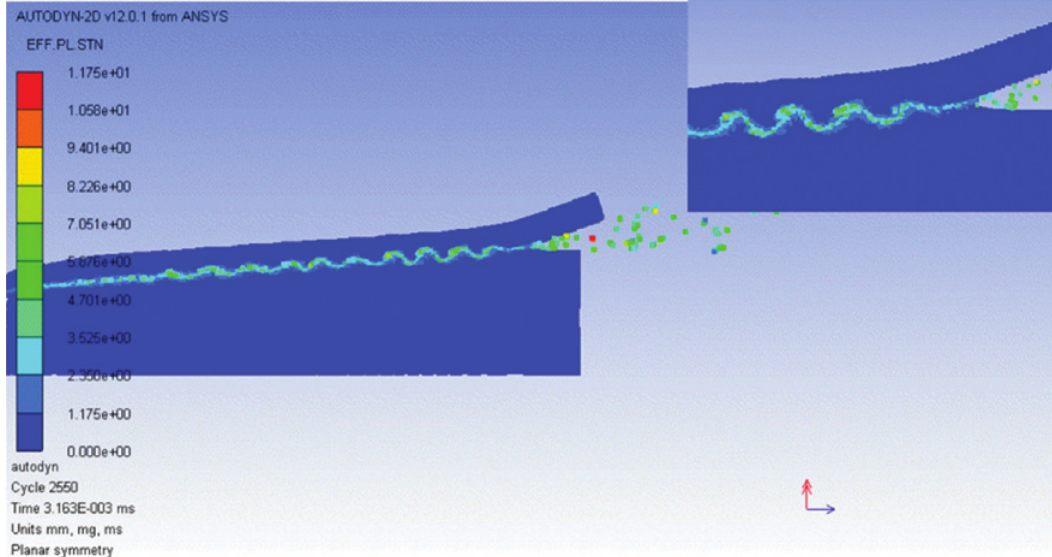
Figure 7: The effective plastic strain distribution of combination in the simulation.